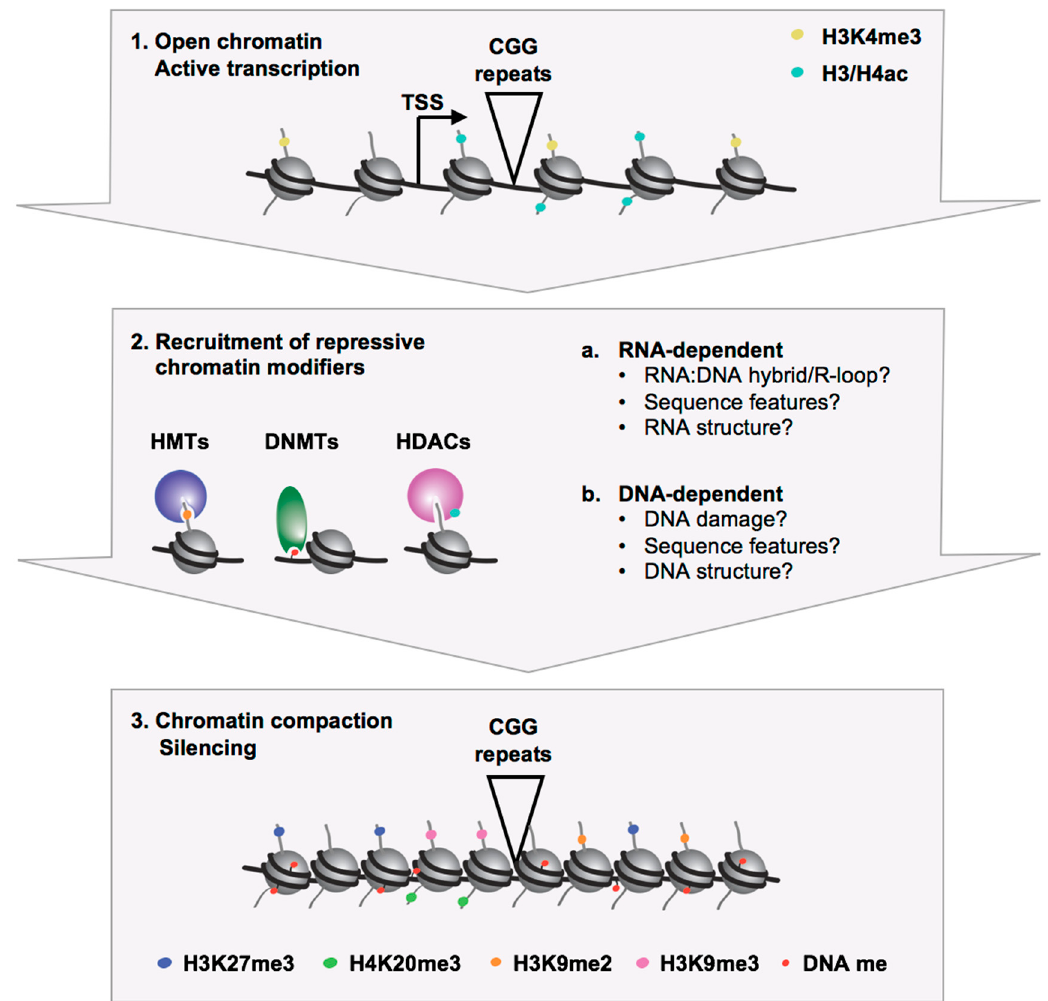
Figure 2. Schematic representation of the recruitment of repressive chromatin modifiers to the FMR1 locus leading to a heterochromatic silenced state in FXS.